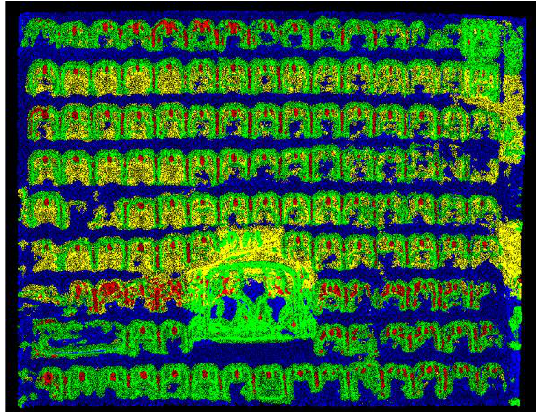
Figure 6. Classification result of point cloud before grotto selection